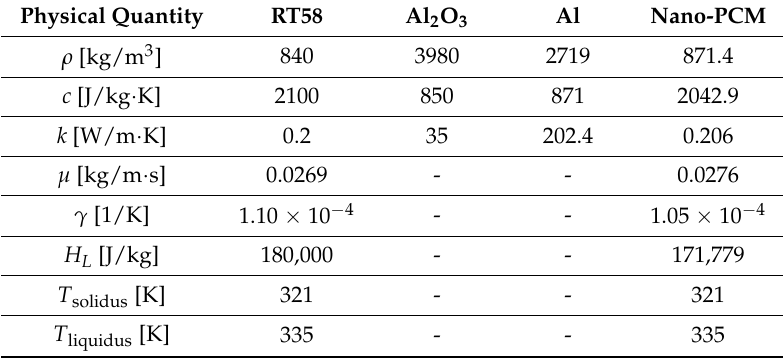
Table 1. Thermal properties of the